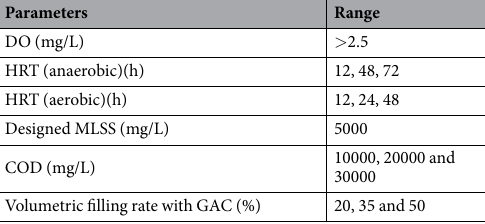
Table 3. Operational conditions.